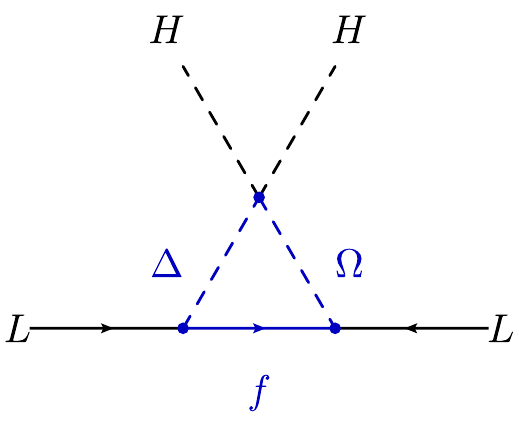
Figure 1 . Diagram responsible for the one-loop generation of neutrino